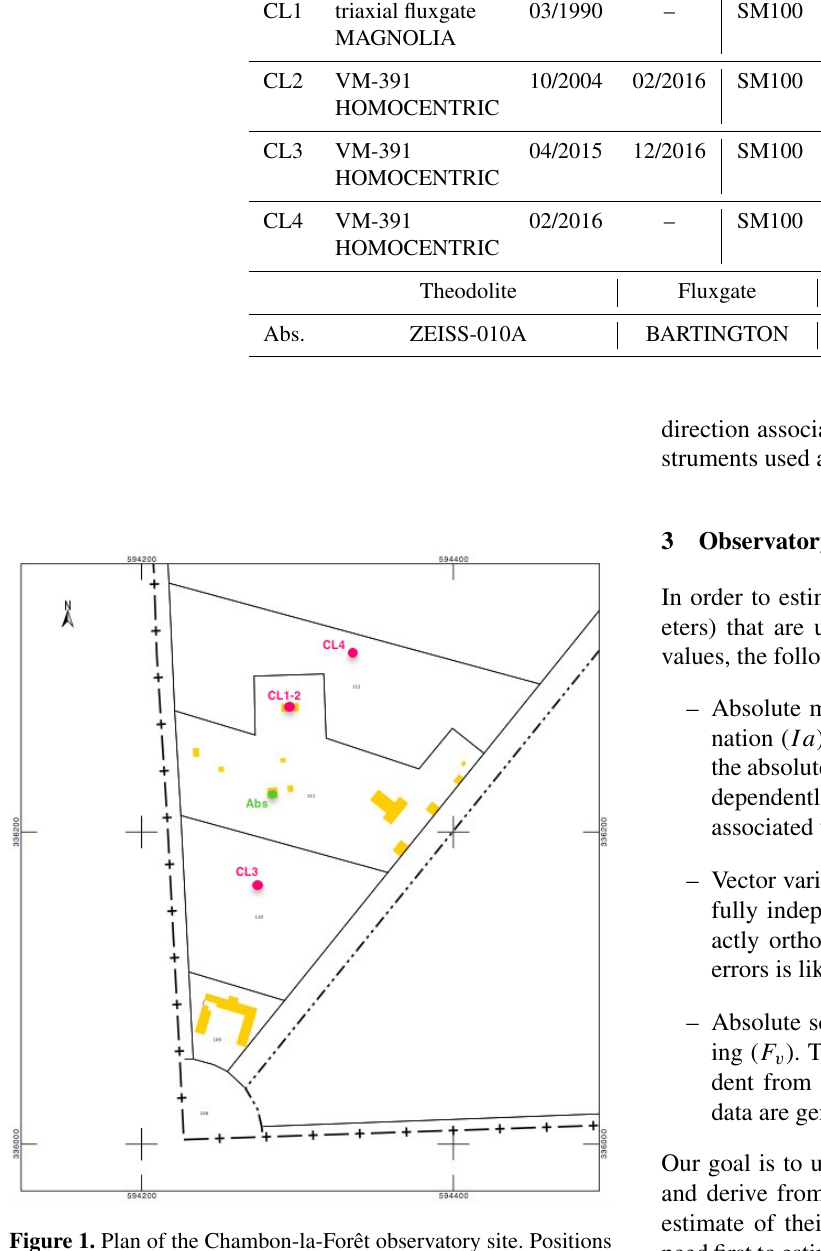
Figure 1. Plan of the Chambon-la-Forêt observatory site. Positions of the instruments used in this study are indicated. Distances are shown on the picture side in metres. Roughly 200m separate CL3 from